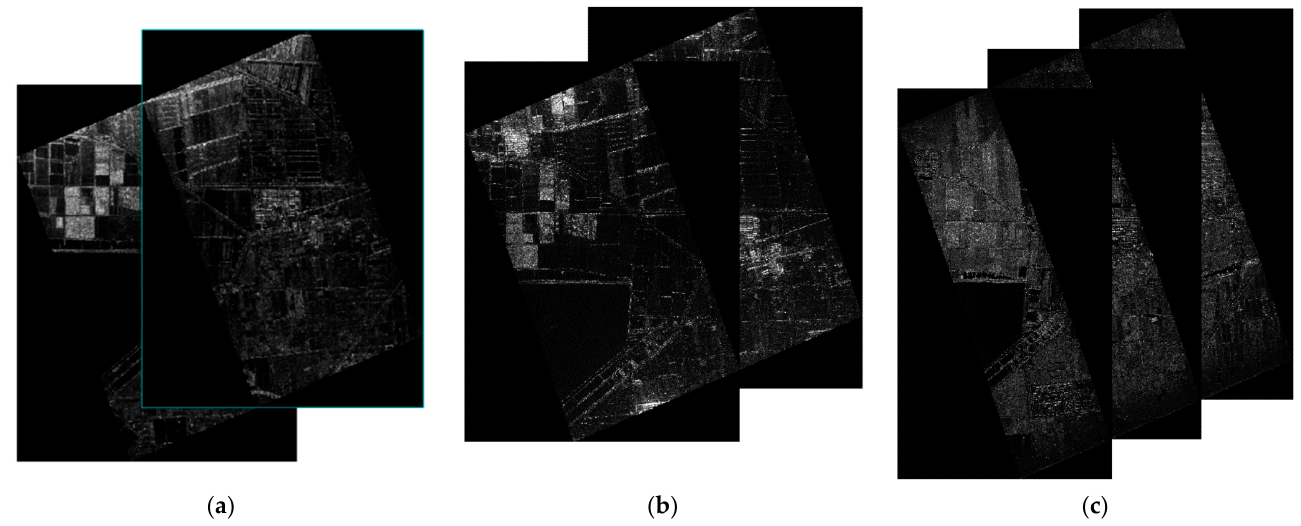
Figure 5. ( a ) Two L-band SAR images. ( b ) Two P-band SAR images. ( c ) Three C-band SAR